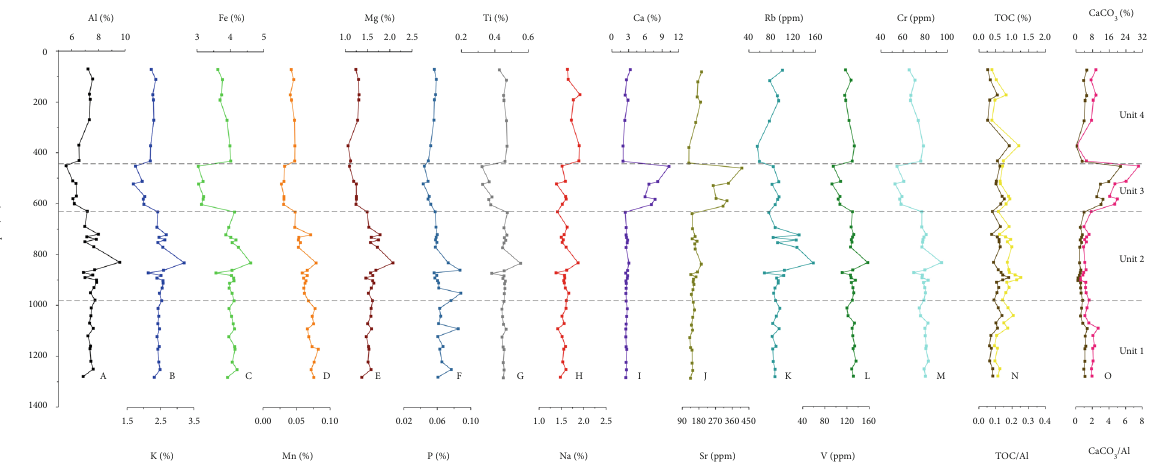
Figure 3: Variations in major and trace elemental concentrations, together with TOC (yellow line), CaCO normalized to Al values (black line) at core 973-4 in the northeastern SCS over the past 42 kyr.